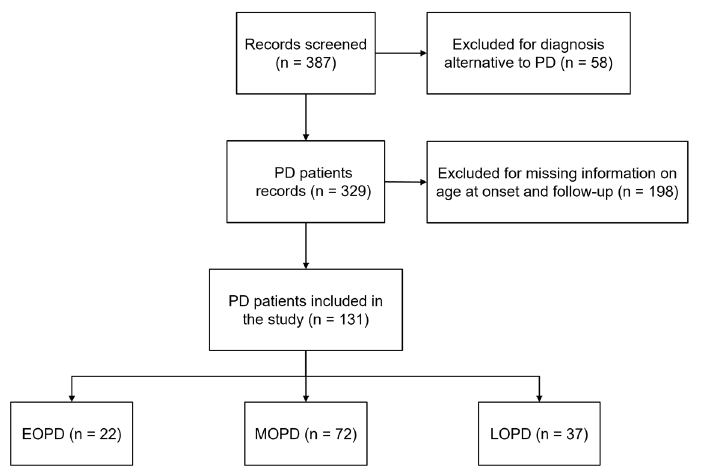
Figure 1. Flowchart of patient selection for the study. EOPD: Early-Onset-PD; MOPD: Middle-On- set-PD; LOPD: Late-Onset-PD; PD: Parkinson’s